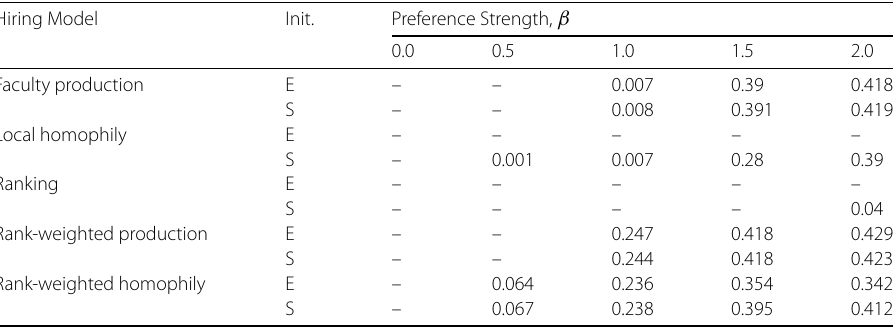
Table S2 Best-fit values of the random hiring parameter p for the Business faculty hiring network. Each entry in the table presents the value of p that minimized the distance between modeled networks and empirical networks for values of preference strength β , initializations (E, Egalitarian; S, Skewed) and hiring models, as shown. For combinations which were unable to plausibly reproduce the properties of empirical networks ( D > 0.1, see Methods), no value of p is given Hiring Model Init.